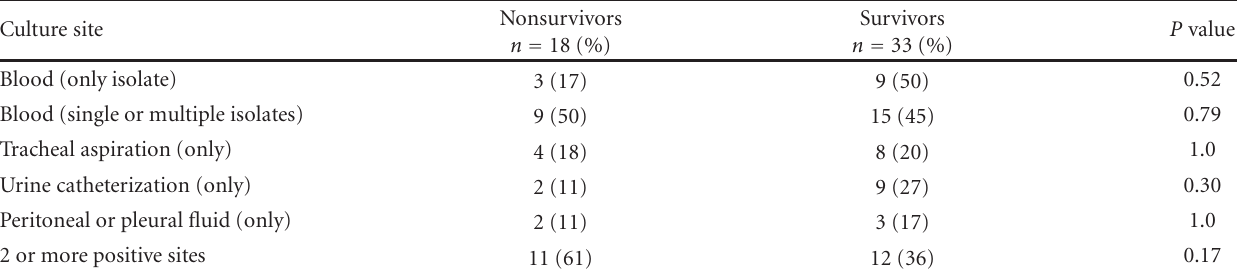
Table 3: Origin of positive culture specimen: comparison between mortality and survivor